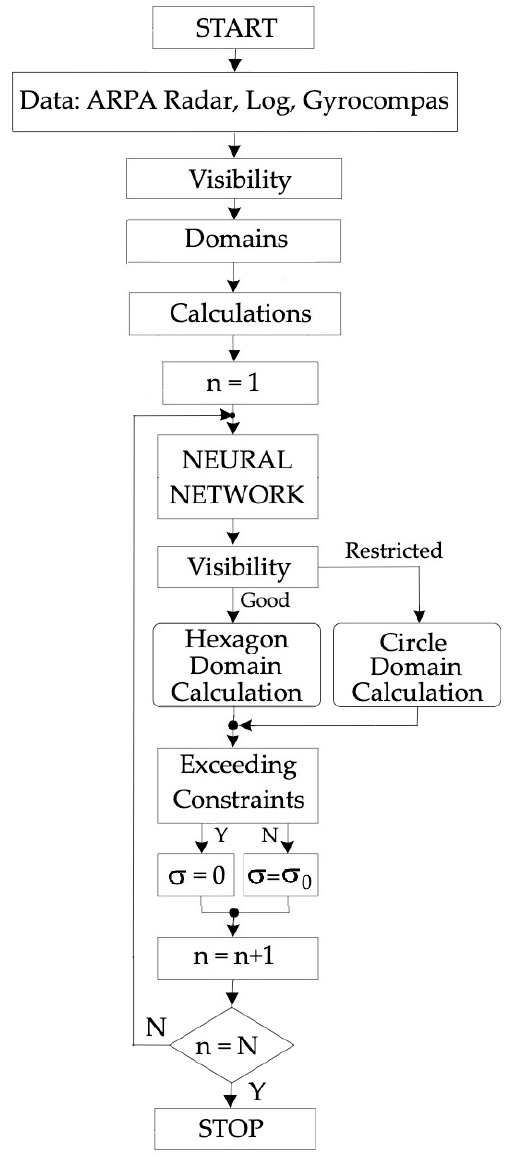
Figure 5. Block diagram of the DONN algorithm for determining a safe dynamic trajectory in a group of autonomous vehicles.